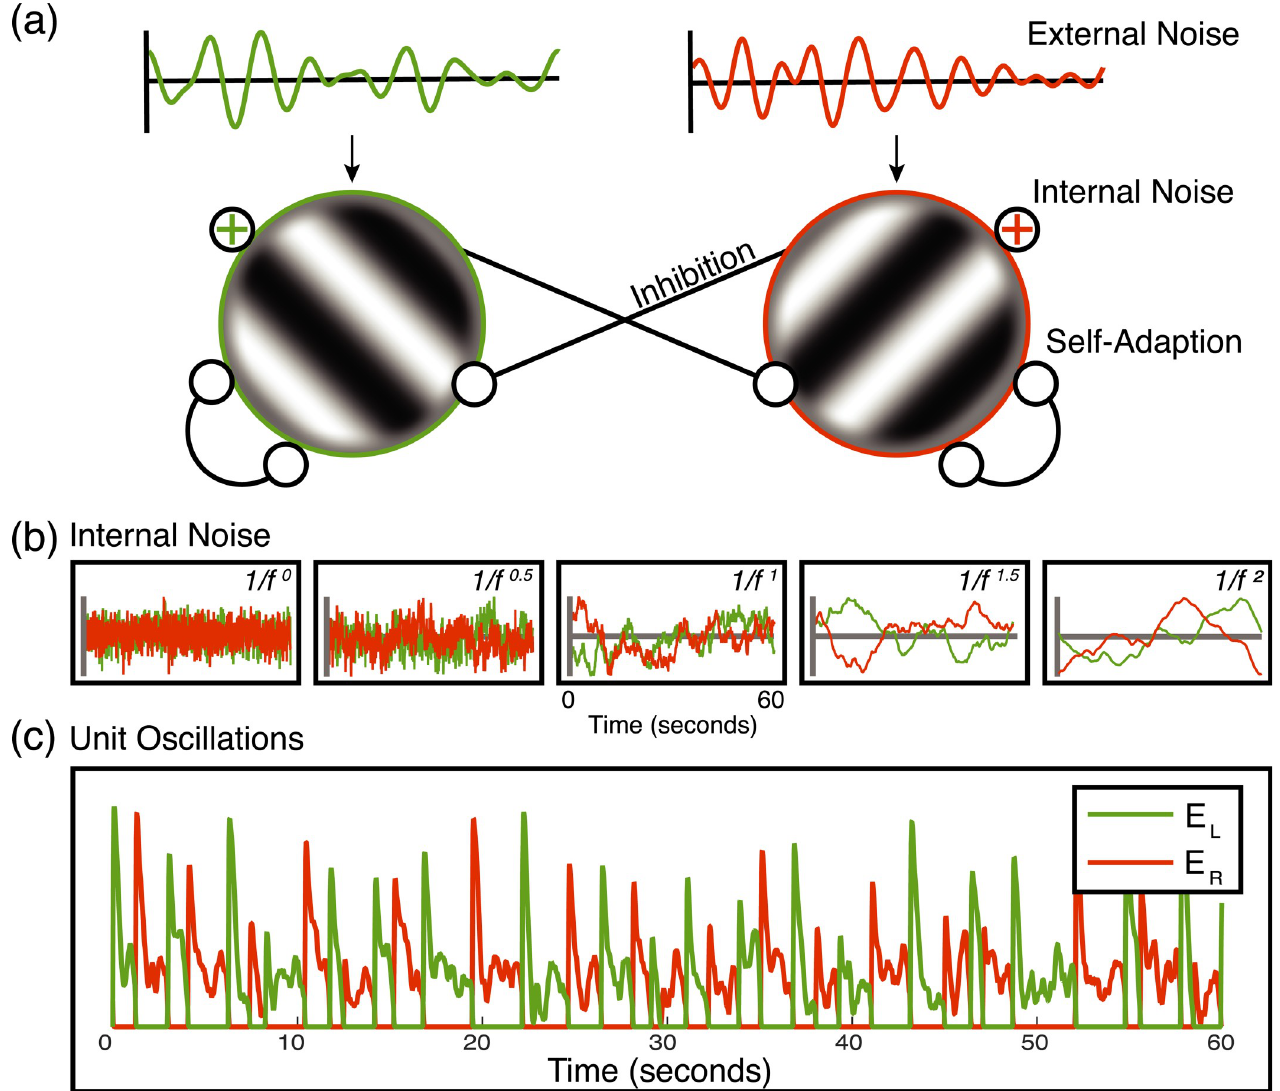
Fig 2. Model details. (a) Model diagram of the two competing units. Each receives as input an independent white noise stream, bandpass filtered at one of five different temporal frequencies (see Methods). The minimum rivalry model [4] defines the oscillatory behaviour of rivalry between two units with self- adaptation and mutual inhibition. We include additive internal independent monocular noise in our model, marked by the (+) symbols. (b) Examples of the five different internal noise spectral slopes ( α = 0–2.0) of the model for the left (green) and right (red) responding units. Noise streams with steeper slopes have an increased relative amplitude of low temporal frequencies relative to high, which leads to slower changes in the noise amplitude. (c) Example oscillatory behaviour of the model for a given trial (60s). The colours represent the responses of the left (green) and right (red) responding